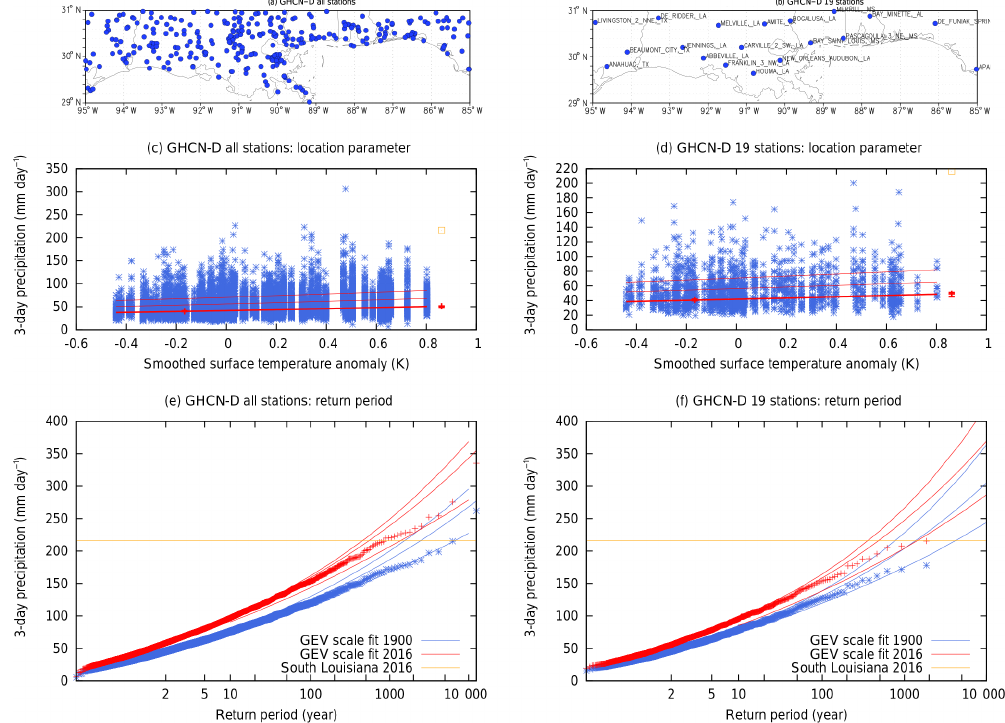
Figure 3. Fit of the annual maximum 3-day average GHCN-D station precipitation on the central US Gulf Coast to a GEV that scales with smoothed global mean surface temperature. (a) Location of all GHCN-D stations with minimum 10 years of data, (c) observations (blue marks), location parameter µ (thick red line versus global mean temperature anomalies, relative to 1980–2010), µ + σ and µ + 2 σ (thin red lines); the two vertical red lines show µ and its 95% CI for the two climates in (e) . (e) Gumbel plot of the GEV fit in 2016 (red line, with 95% uncertainty estimates) and 1900 (blue line); marks show data points drawn twice: scaled up with the trend to 2016 and scaled down to 1900. The yellow square (line) denotes the intensity of the observed event at Livingston, LA. Panels (b, d, f) are the same as (a, c, e) but for 19 GHCN-D stations with a minimum 80 years of data and minimum spatial separation of 0.5 ◦